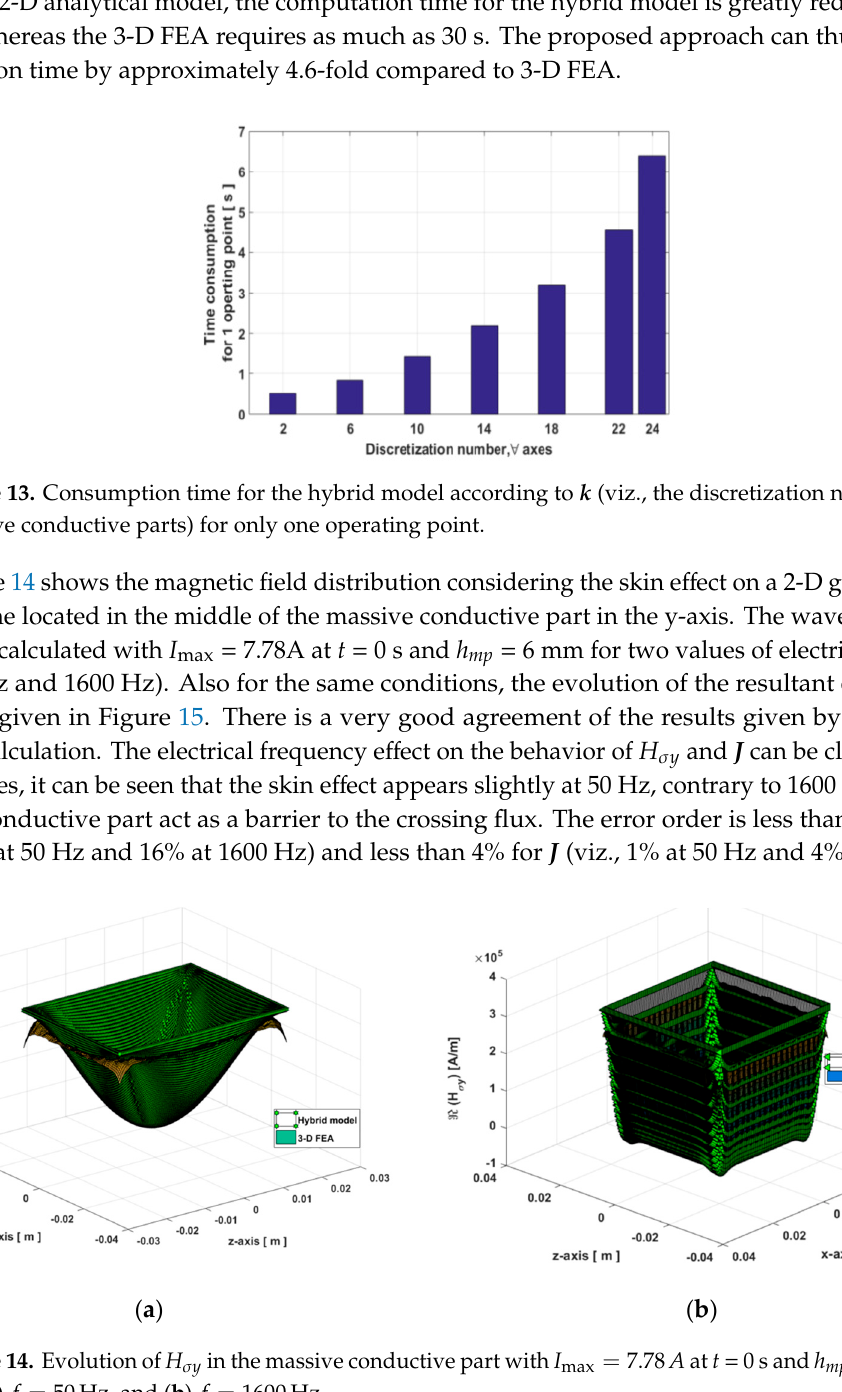
7.78 I at = 0 s t and max